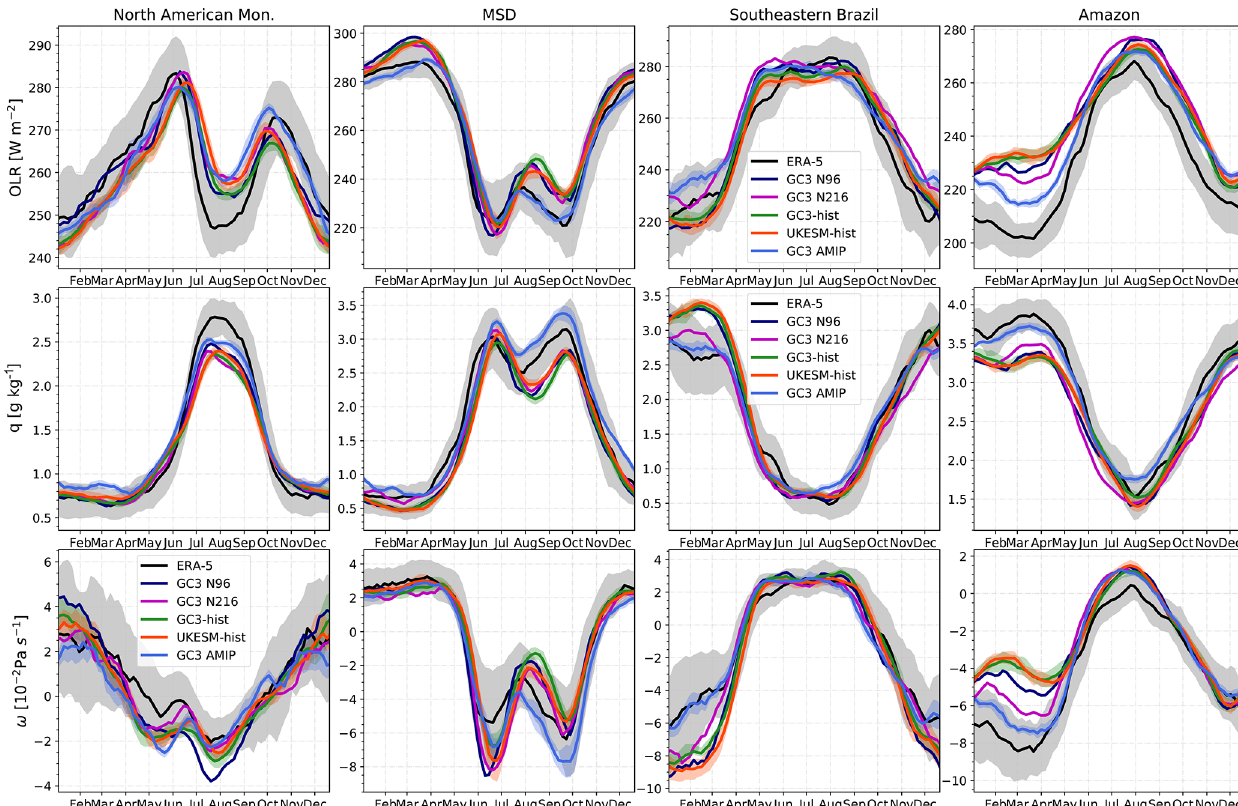
Figure 9. Pentad-mean (upper) outgoing longwave radiation (OLR), (middle) specific humidity at 500hPa and (lower) ω at 500hPa. These are shown from left to right for the North American monsoon, the midsummer drought, southeastern Brazil and the core Amazon. The uncertainty in ERA5 data, shown as faint grey shading, was estimated by bootstrapping with replacement of the ERA5 record 10000